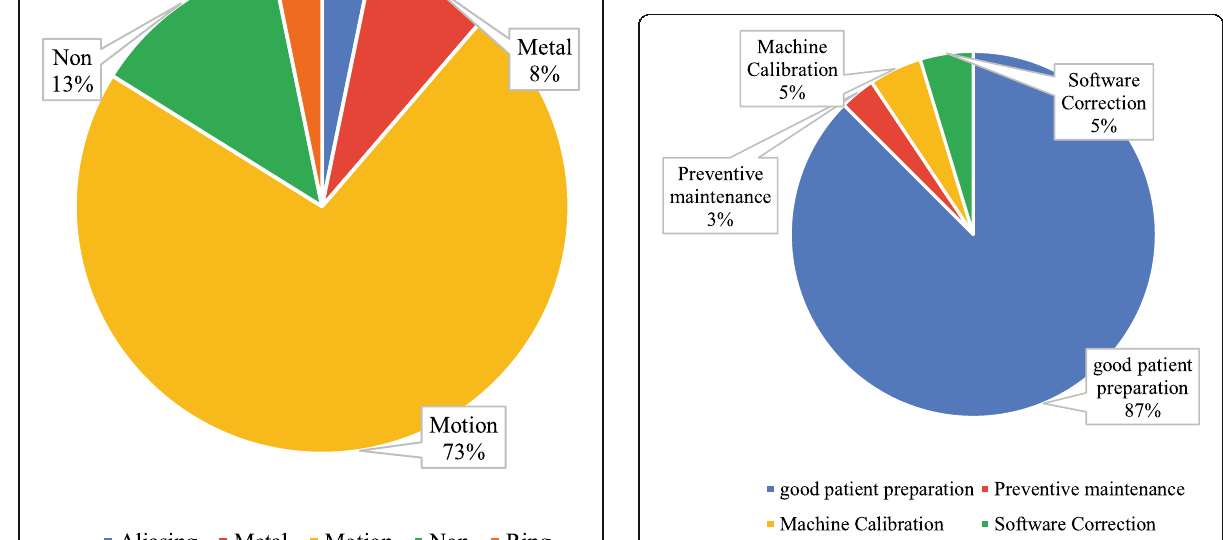
Fig. 8 What is the appropriate technique used to avoid or reduce